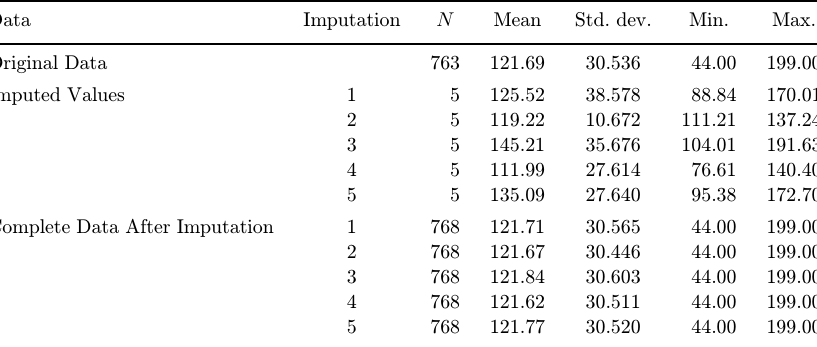
Table 2. Multiple imputations for V 2.